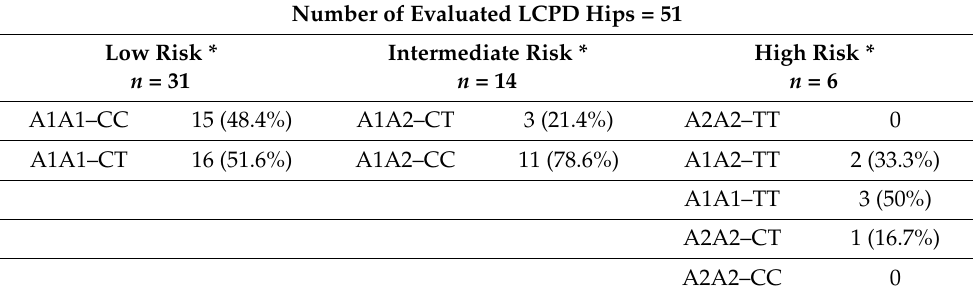
Table 2. Haplotype distributions among the LCPD hips analyzed.